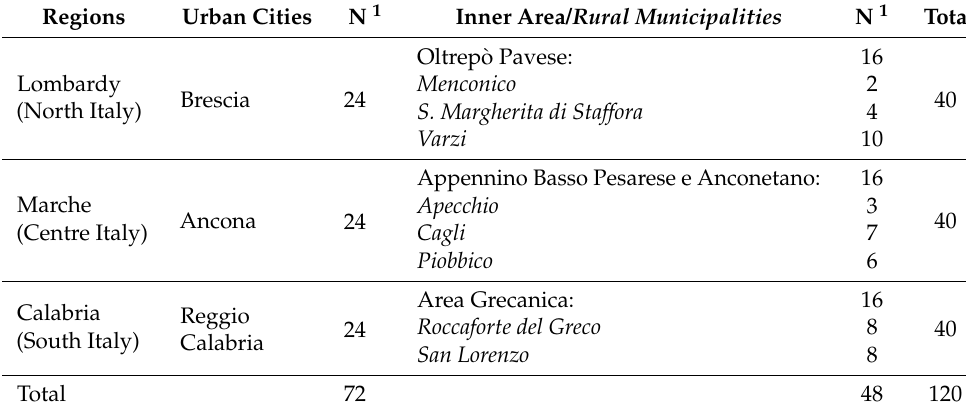
Table 1. Regions and